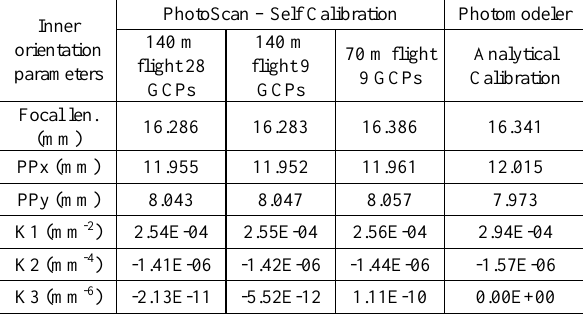
Table 4 - Inner orientation parameters of the self and analytical calibration.